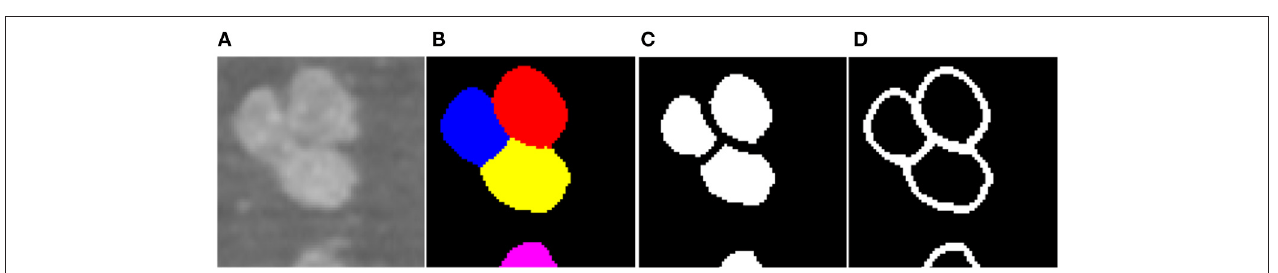
FIGURE 2 | Flowchart of the proposed method.